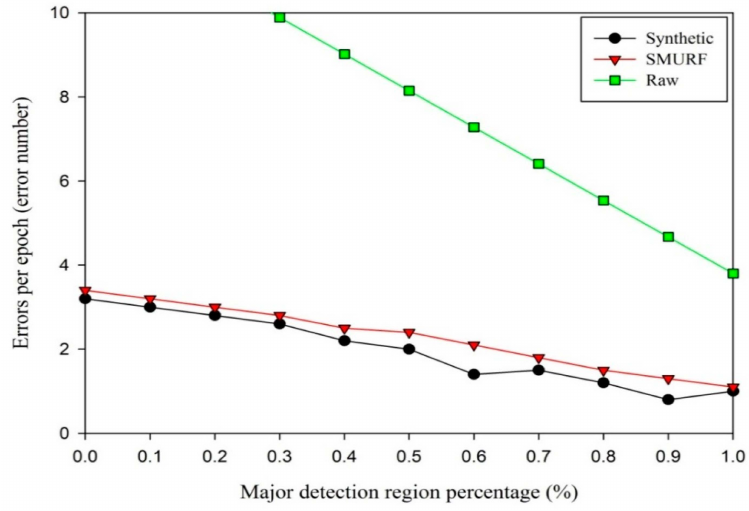
Figure 6. Average errors per epoch as MajorPercentage